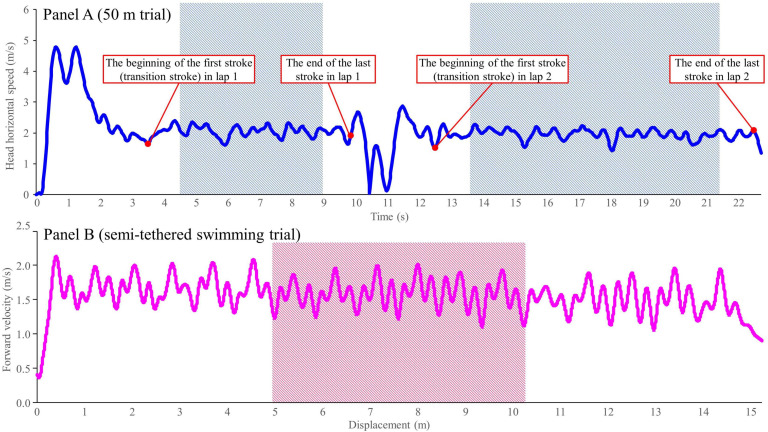
Examples of collected data from the 50 m front crawl (panel A) and semi-tethered swimming (panel B) trials. The shaded area shows the range of data used for the analysis.